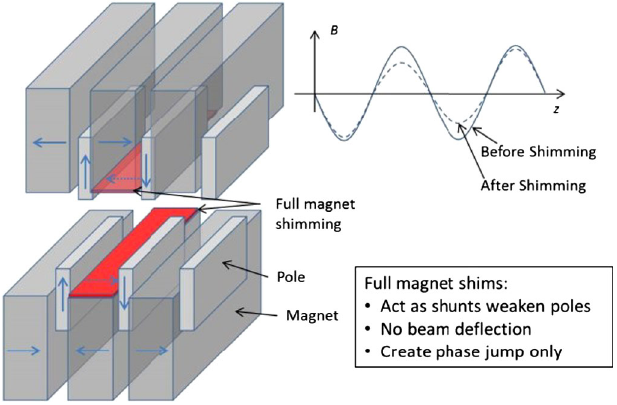
FIG. 8. Principle of full magnet